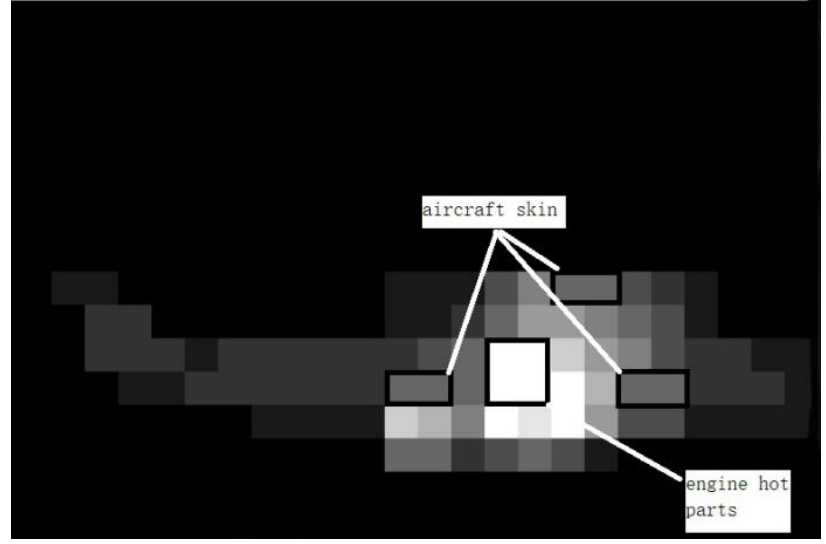
Figure 8. Middle-wave infrared image of civil aviation aircraft.